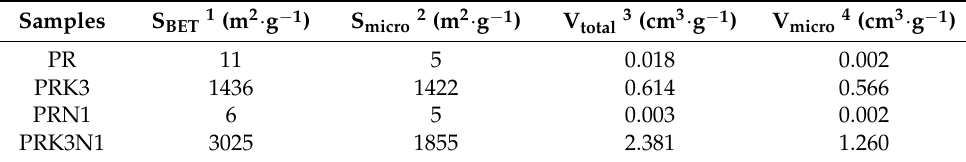
Figure 5. ( a ) Nitrogen absorption–desorption isotherms, ( b ) the pore size distribution curves of PR, PR, PRK3, PRN1 and PRK3N1. PRK3, PRN1 and PRK3N1. Table 3. The pore structural parameters of all